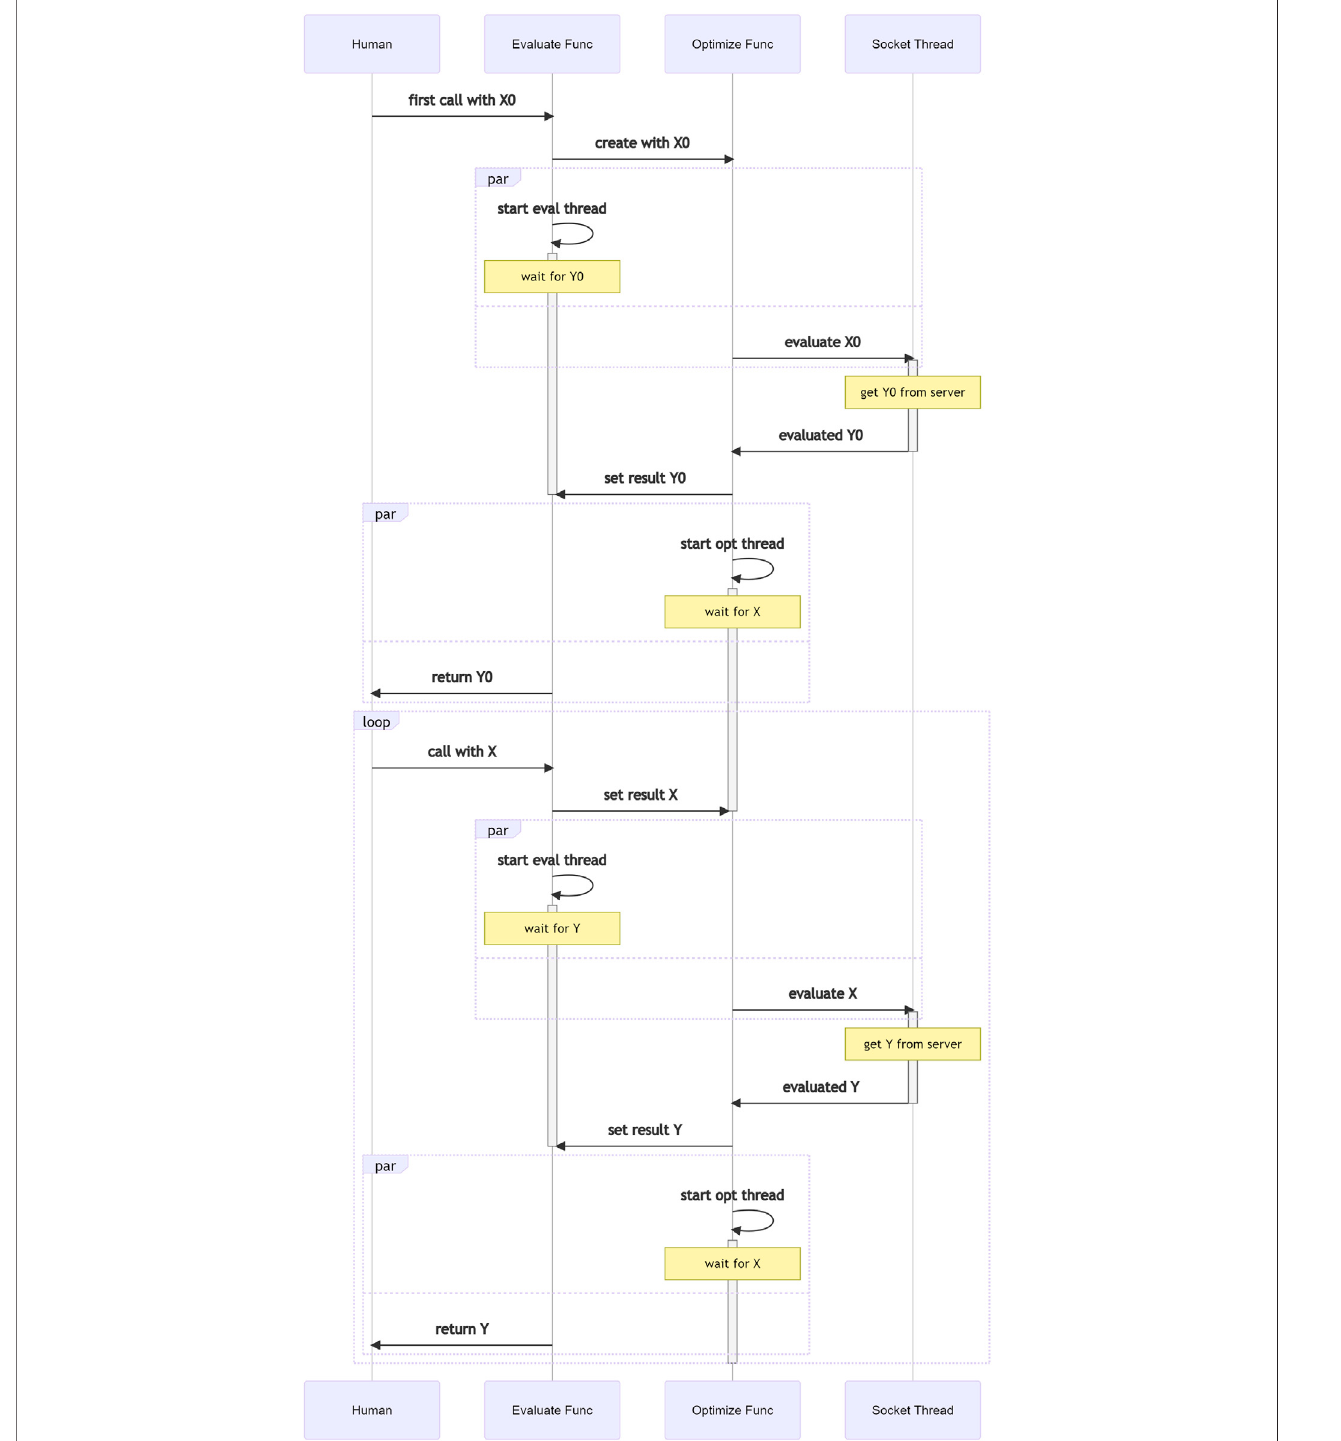
FIGURE 6 | Multi-threading logic that happens when calling the Teeportized evaluate function from the use_evaluator (id) API to get some data X evaluated.